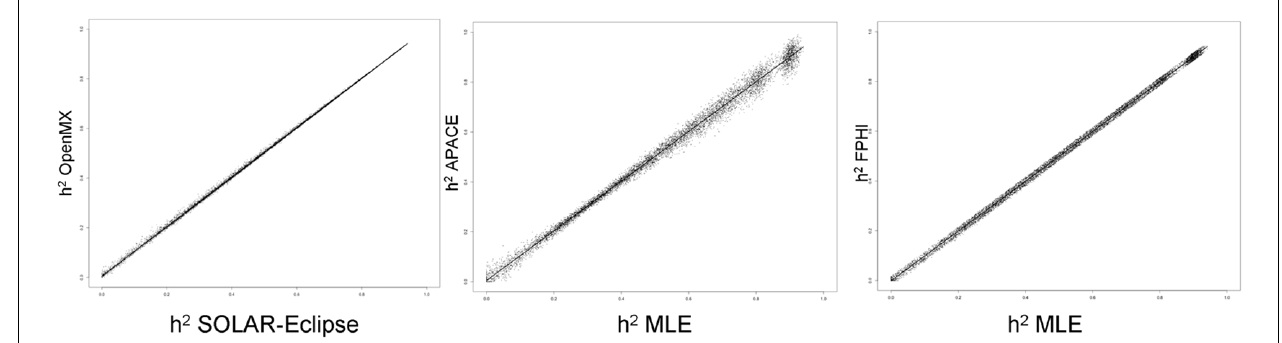
FIGURE 1 | The scatter plot of heritability estimates for 10,000 simulated traits are shown for two ML-based approaches (left). Heritability estimates by two approximation approaches: accelerated permutation inference for ACE (APACE; center) and fast permutation heritability inference (FPHI; right) were plotted vs. the average maximum likelihood estimation (MLE) based values.